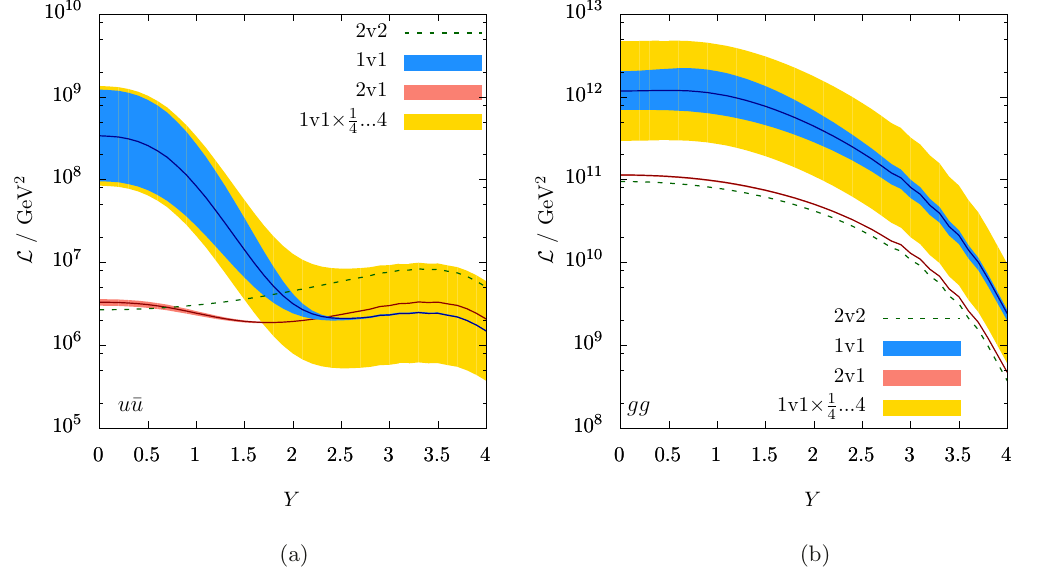
Figure 17 . Double parton scattering luminosities with Q 1 = Q 2 = 80 GeV at √ s = 14 TeV, one with rapidity Y and the other with rapidity The parton combinations a 1 a 2 b 1 b 2 are u ¯ u ¯ uu + ¯ uuu ¯ u (a) and gggg